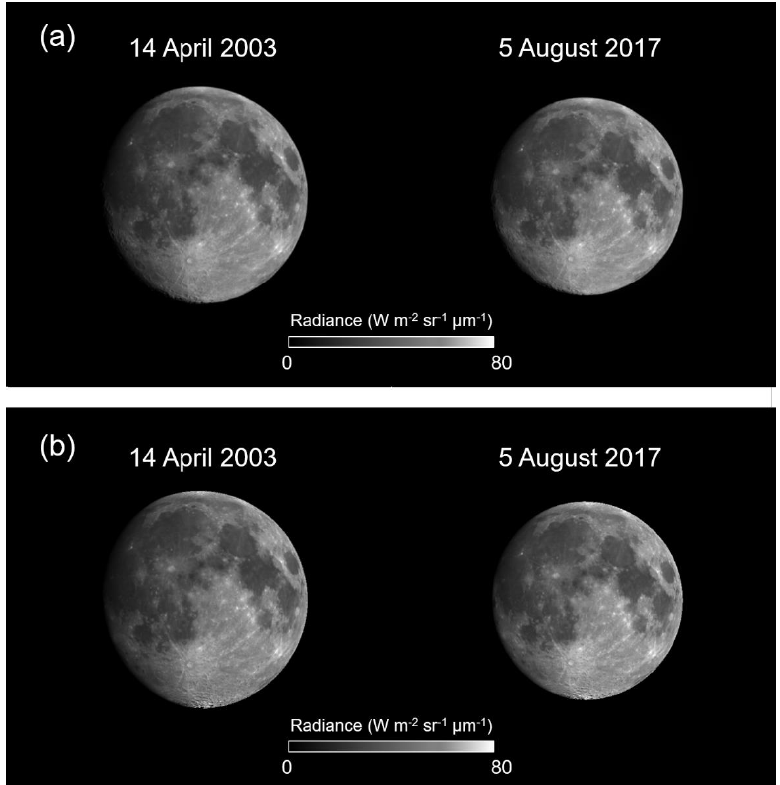
Figure 4. ( a ) Observed images of the Moon by VNIR Band 1 (520 – 600 nm) on 14 April 2003 and 5 August 2017 whose oversampling effects were corrected, whereas the effects from the sensor sensitivity degradation were not corrected. ( b ) Simulated images of the Moon for the two observations using the SP model.